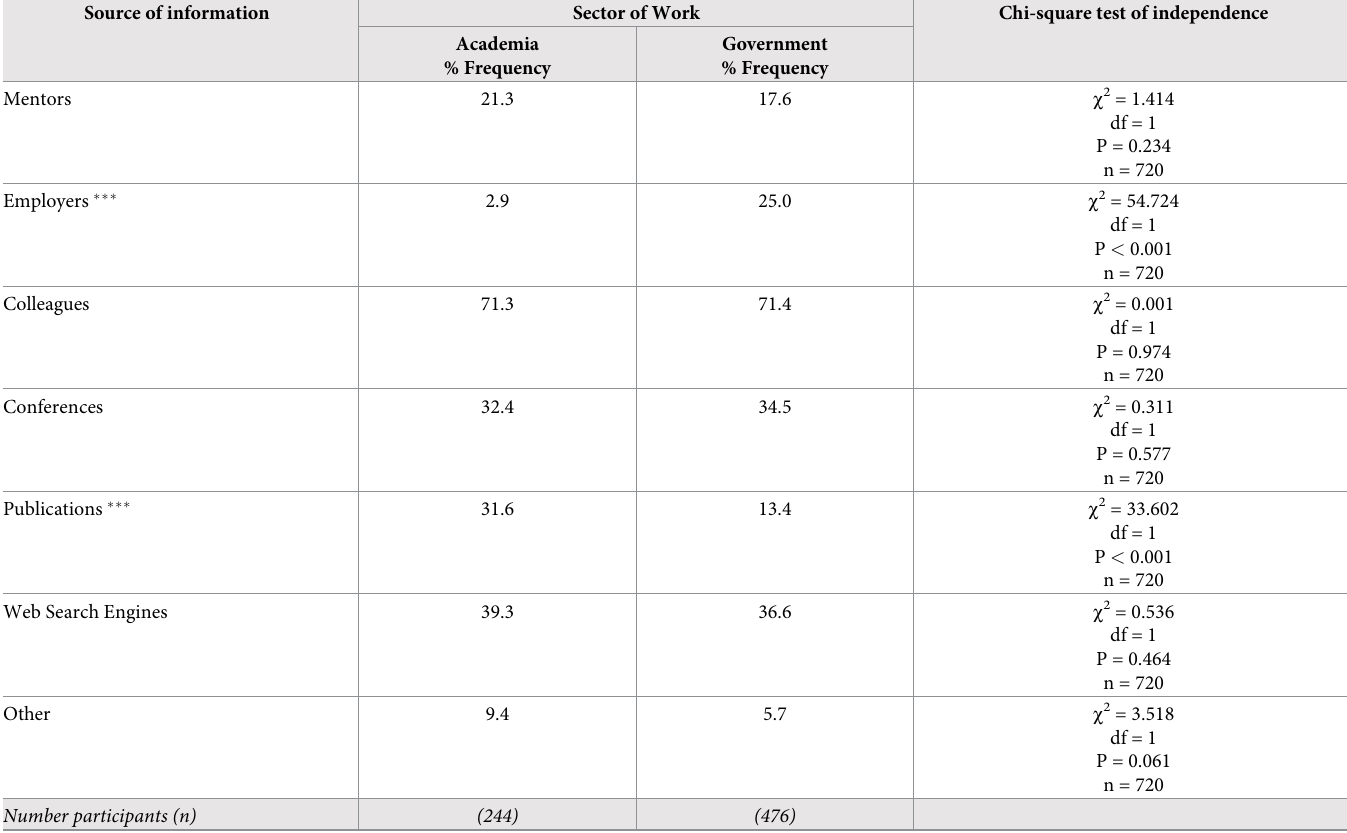
Table 10. Frequency of source of information where participants learned about web-based species occurrence information